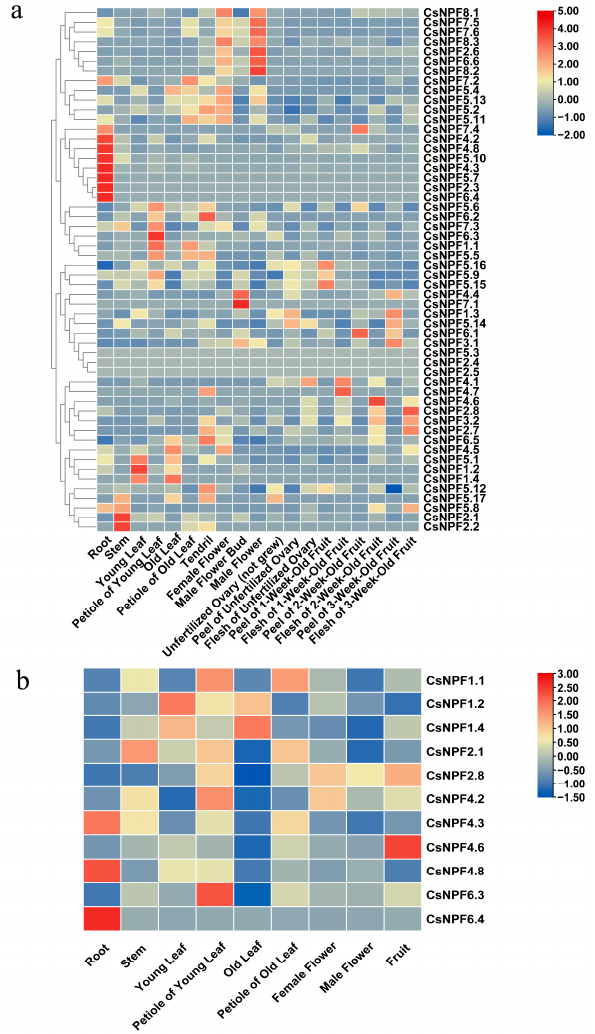
Figure 6. Tissue-specific expression of NPF genes in cucumber. ( a ) The expression profiles of CsNPF genes in 19 tissues were investigated based on public transcriptome data. Gene expression levels were evaluated as log2 − transformed fragments per kilobase of exon model per million mapped fragments (FPKM) values. ( b ) Transcript levels of 12 CsNPFs were analyzed using qRT–PCR in roots, stems, young leaves, petiole of young leaves, old leaves, petiole of old leaves, female flowers, male flowers, and fruits. Data from cucumber roots were selected as standards, to measure the relative expression of genes in other tissues, and the expression levels of each gene in roots was set as